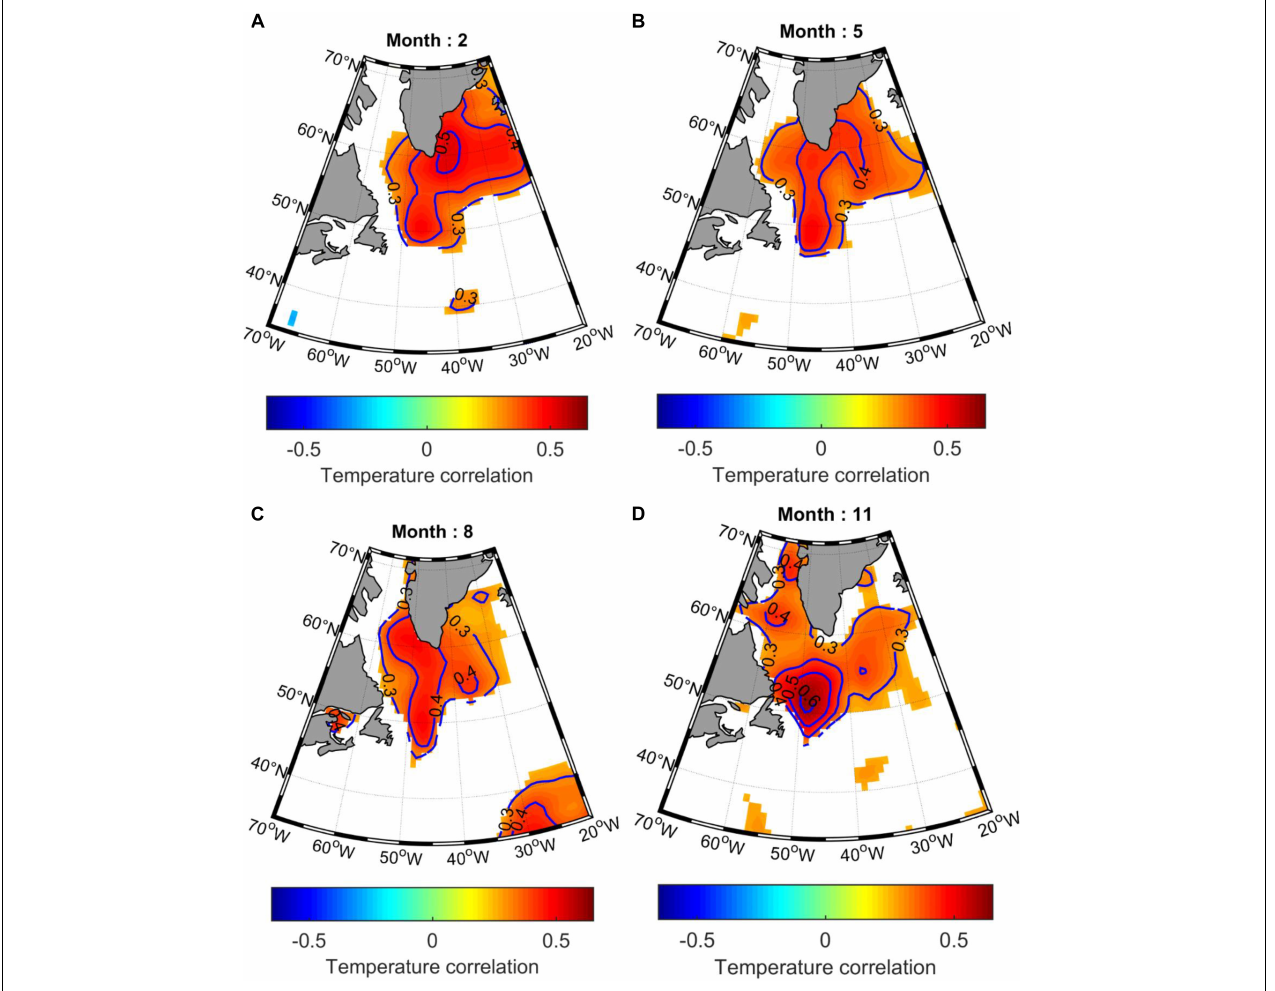
FIGURE 7 | Spatial Pearson correlations between A. islandica SGI and detrended monthly near surface (0–100 m) temperature, from the UK Met Office Hadley centre EN4.2.1, represented for (A) mid-winter (February), (B) mid-spring (May), (C) midsummer (August), and (D) mid-fall (November). Only significant ( p < 0.05) correlation coefficients are